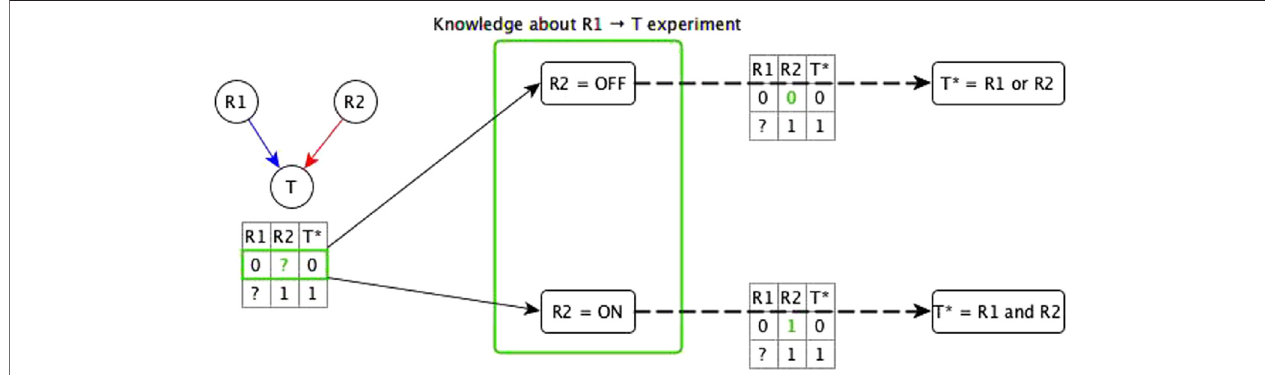
FIGURE2| Illustrationoftheuseofknowledgeabouttheexperimentalsettingtoresolveincompatibility.AtargetnodeThastworegulators;oneisconcludedtobe necessary (R1) from experiment/literature and the other is concluded to be suf fi cient (R2) from experiment/literature. The truth table below the network diagram shows these relationships: R1 → T necessary relationship means that when R1 is constitutively OFF, T stabilizes to OFF; R2 → T suf fi cient relationship means that when R2 is constitutively ON, T stabilizes to ON. Since this is an incompatibility, we consider two assumptions about the state of R2 (denoted by green “ ? ” ) in the experiment that concluded R1 to be necessary — the row marked in green in the truth table below the network. The fi rst assumption is when R2 is OFF. In this case, there are two possiblefunctionsforT*:1)T*=R1andR2,and2)T*=R1orR2.IftherulewereT*=R1andR2,TwouldneedtobeOFFinthe fi rstrowofthetruthtable,independentof the state of R1, hence, this leads us to conclude that the rule is T* = R1 or R2 — with the corresponding truth table shown on the top dashed edge. When R2 = OFF, this rulebecomesT*=R1,whereR1isindeedsuf fi cientandnecessaryforT,makingthe “ necessary ” classi fi cationofR1 → Tvalid.ThesecondassumptioniswhenR2isON butTisOFFwhenR1isOFF,whichleadsustoconcludethattheruleisT*=R1andR2(seebottomdashededge).WhenR2=ON,thisruleisreducedtoT*=R1,where R1 is suf fi cient and necessary for T, making the “ suf fi cient ” conclusion about R1 → T valid. These two assumptions fall under the two templates of the dominant regulatorsresolutionmethod.DuetocommutativityoftheBooleanoperators,theresultingBooleanfunctionwouldbethesamewhethertheknowledgeisaboutthe R2 → T experiment or about the R1 → T